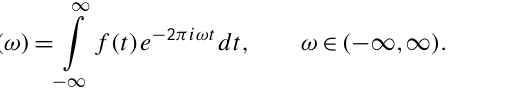
) . (Middle) The Fig. 1. (Top) A simple time series: f (t) = sin ( πt 3 . 2 Figure 1: (Top) A simple time series: f ( t ) = sin( πt ). (Middle) The adjusted time series obtained by removing 3 . 2 adjusted time series obtained by removing the line which connect the line which connect two endpoints of the original time series. (Bottom) We do the odd extension for the two endpoints of the original time series. (Bottom) We do the odd adjusted time series extension for the adjusted time